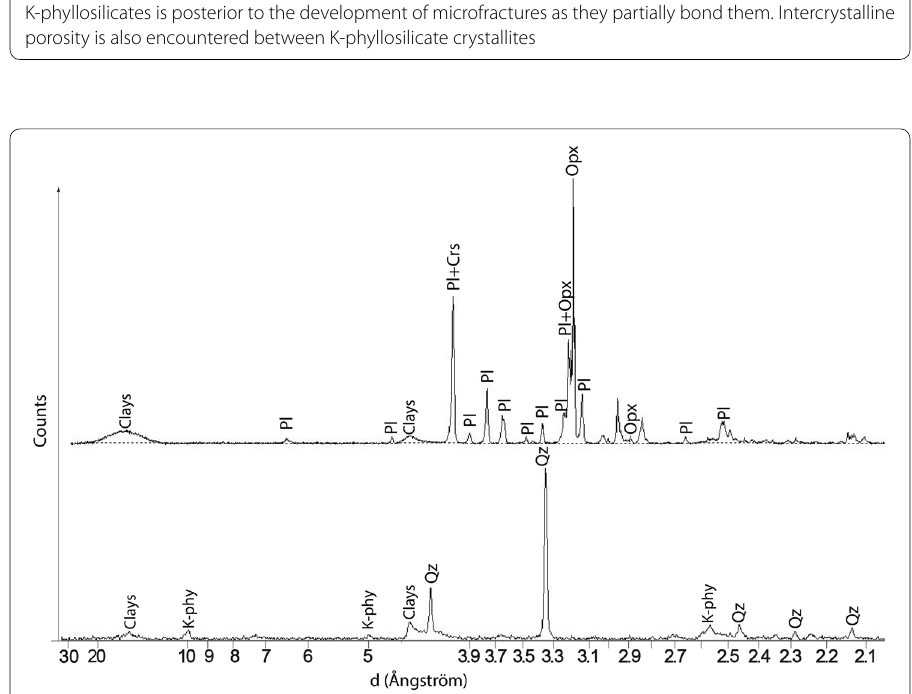
Fig. 6 X-ray diffractograms performed on whole rock. Comparison of fresh (above) and altered facies (below). Pl plagioclase, Opx orthopyroxene, Qz quartz, Crs cristobalite, K-phy